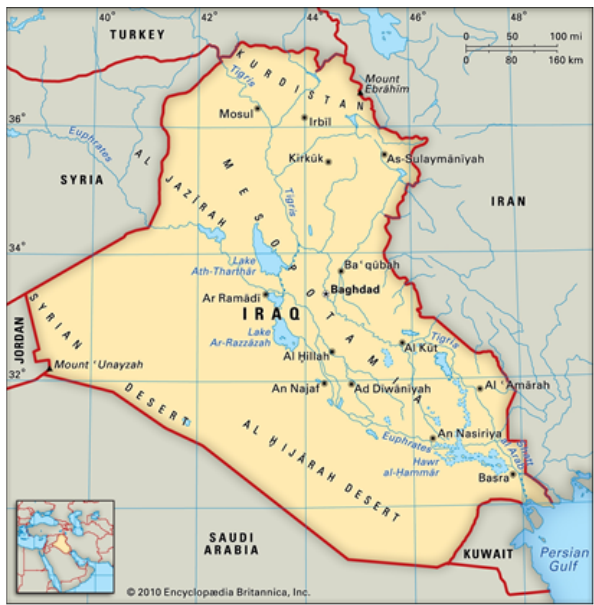
Fig. 1. Map of Iraq showing the Tigris and Euphrates Rivers (Ency- clopaedia Britannica, 2010).